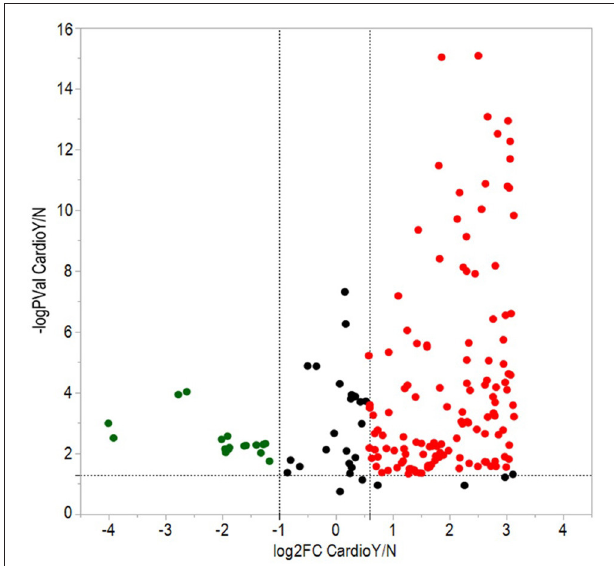
FIGURE 3 | Volcano plot of differentially expressed proteins between patients with and without CVAEs after treatment with CFZ. Negative log 10 p -values were plotted on the y-axis, and log 2 normalized fold changes expression levels on the x-axis. Significant differential expression with p -value threshold values ( α = 0.05) was detected at < 0.5 or > 1.5-fold changes. Red and green dots indicate up- and down-regulated proteins in patients with CVAEs relative to patients without CVAEs.